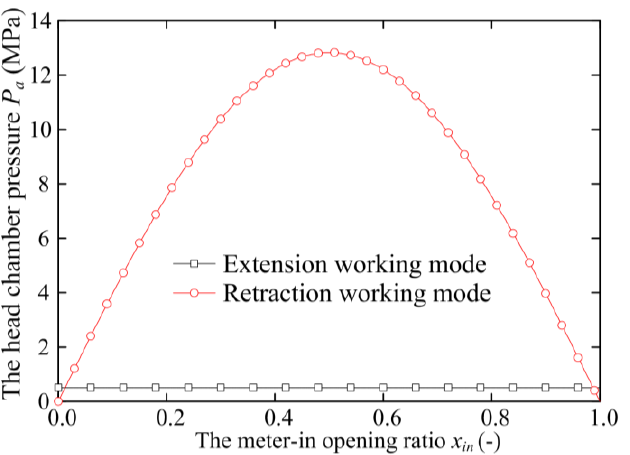
Figure 23. The variations of the head chamber pressure P a of HPCIMS.